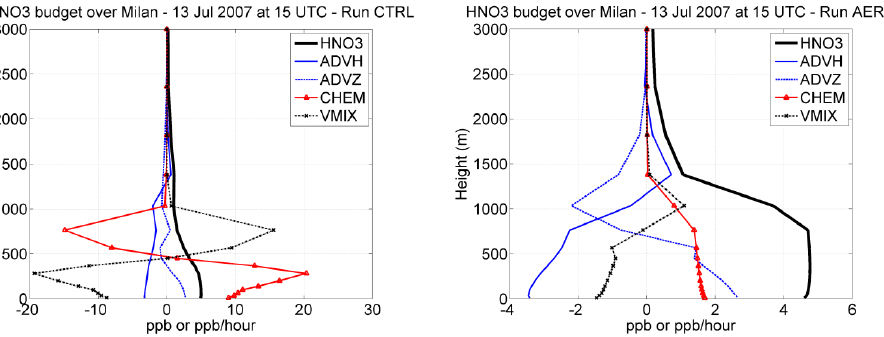
Figure 11. Same as Fig. 9 but for nitric acid (HNO 3 ) and units in ppb: on the left the reference simulation (CTRL); on the right a sensitivity simulation with aerosol chemistry switched off (AERO). Please note the different abscissa ranges.